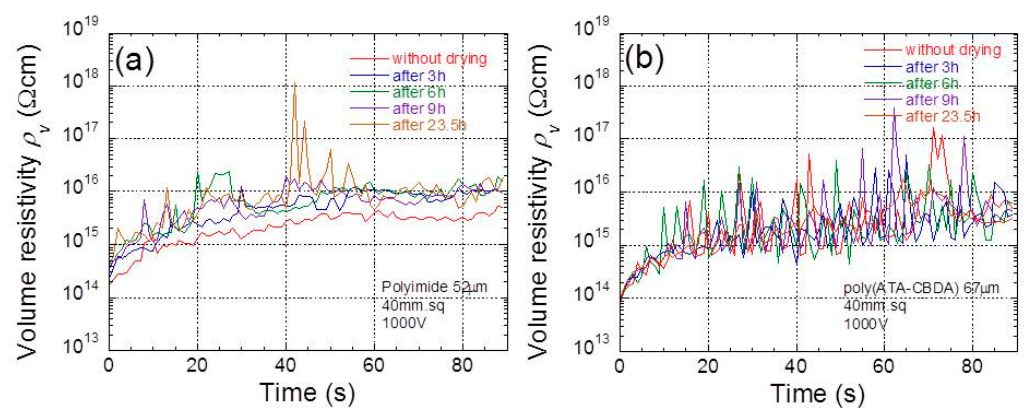
Figure 7. Time profiles of electric resistivity at 1000 V for ( a ) polyimide and ( b ) biopolyimide films with various drying times (film size: 40 mm × 40 mm).